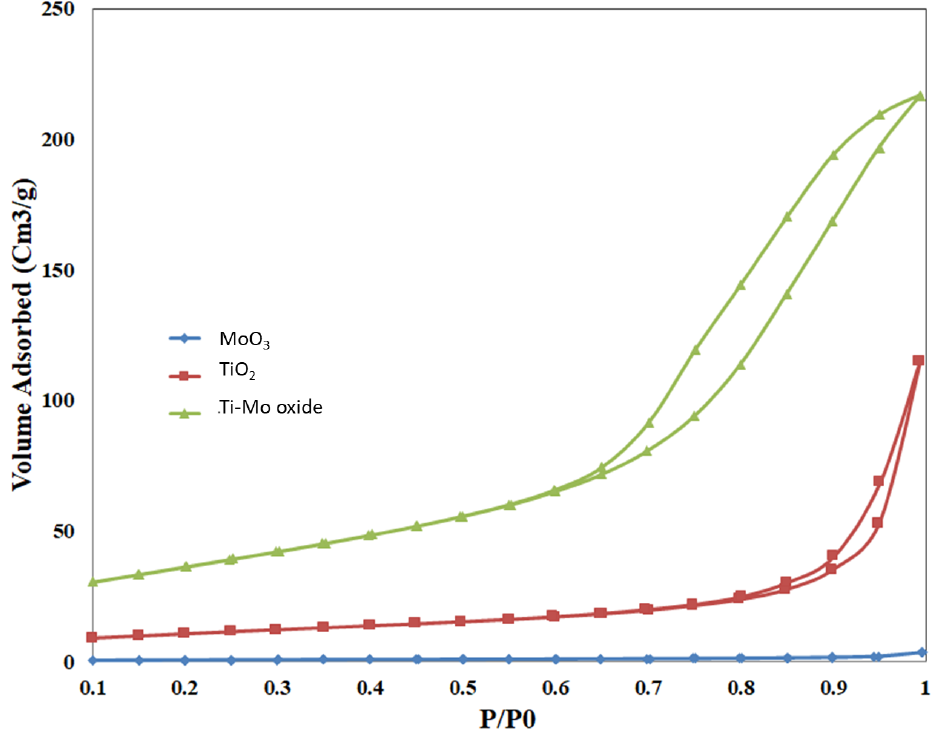
Figure 6. Sorption of nitrogen isotherms for the pure oxides and Ti-Mo NC. Deviations between adsorption and desorption curves were observed for all samples with noticeable hysteresis for Ti-Mo NC and to a lower extent for the pure TiO 2 . The hys- teresis loop for pure TiO 2 and Ti-Mo NC follows type H3 hysteresis according to the